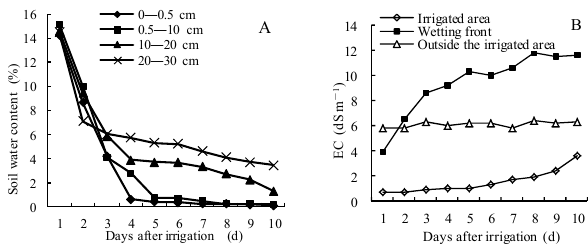
Figure 3. ( A ) Soil moisture dynamics in the irrigated area under different soil depths; ( B ) salt accumulation process in different areas around the emitter.